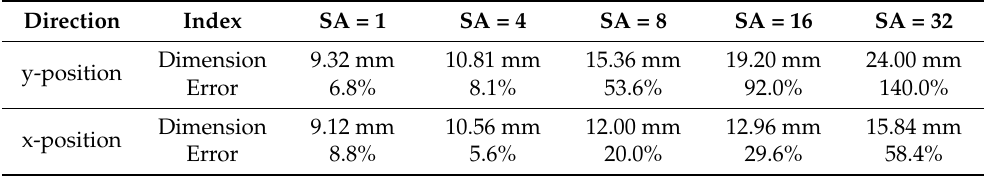
Table 1. Reconstruction of the dimensions and errors of the nylon